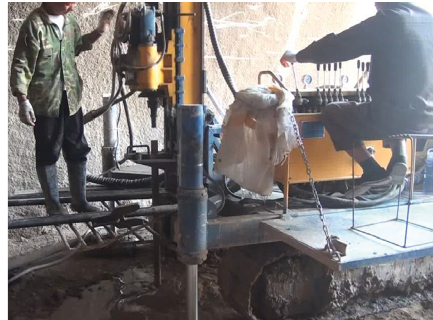
Figure 5: Construction of vertical jet grouting